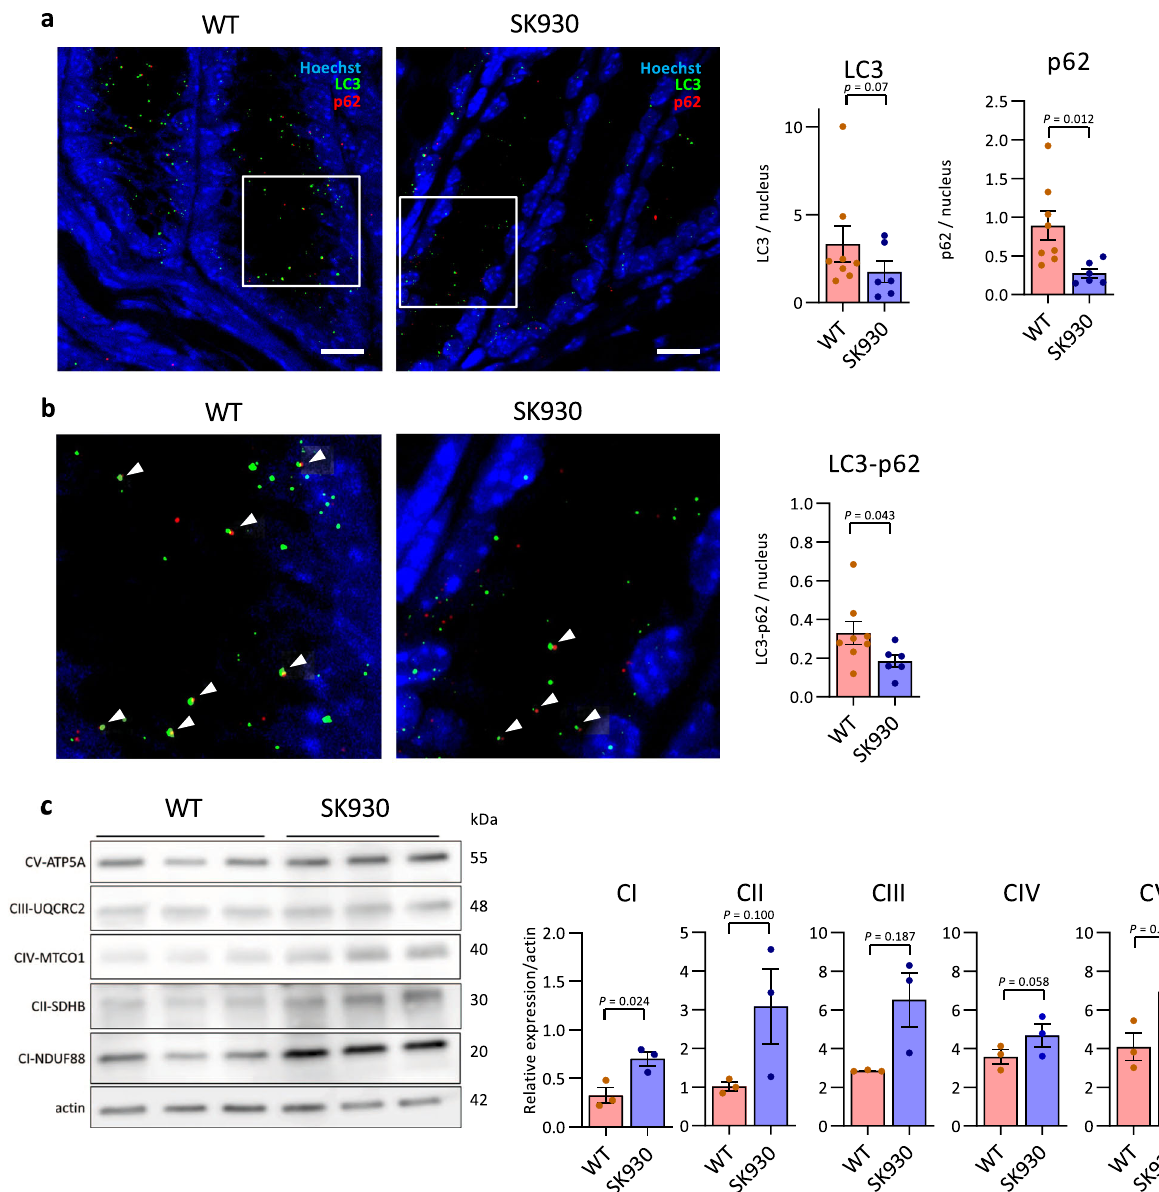
Fig. 3 Bacterial putrescine activates autophagy and OXPHOS in CECs. a , b Representative microscopic images of LC3 and p62 and its enlarged view. Green and red dots indicate LC3 and p62, respectively. Nuclei are stained with Hoechst (blue). The white arrowhead indicates LC3-p62 double-positive dots. Scale bars: 10 µ m. Three randomly selected areas were examined per slide (WT: n = 8, SK930: n = 6, independent animals). c Western blot analysis of OXPHOS complex I-V (CI-CV) in CECs of gnotobiotic mice ( n = 3, independent animals). All data shown represent the mean ± SEM. Statistical signi fi cance was calculated using the Welch ’ s t -test ( a , p62 and c ) (two-sided), Mann – Whitney test with ( a , LC3 and b , LC3-p62)